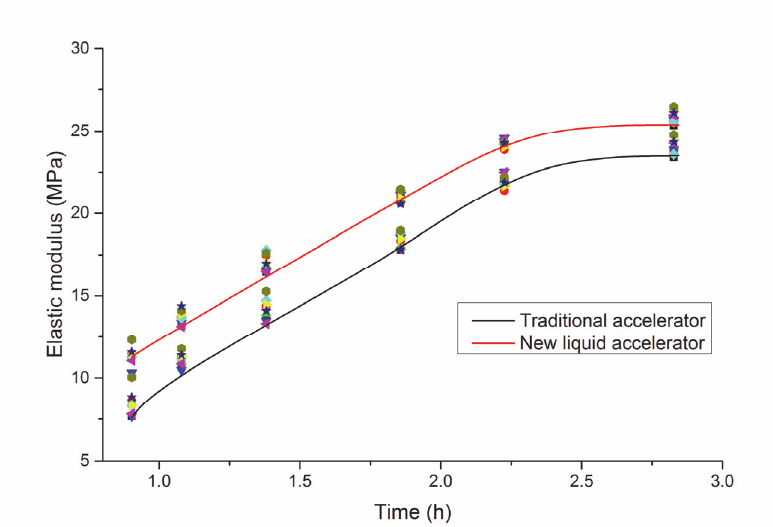
Figure 4: Elasticity modulus-time regression curve of shotcrete added with